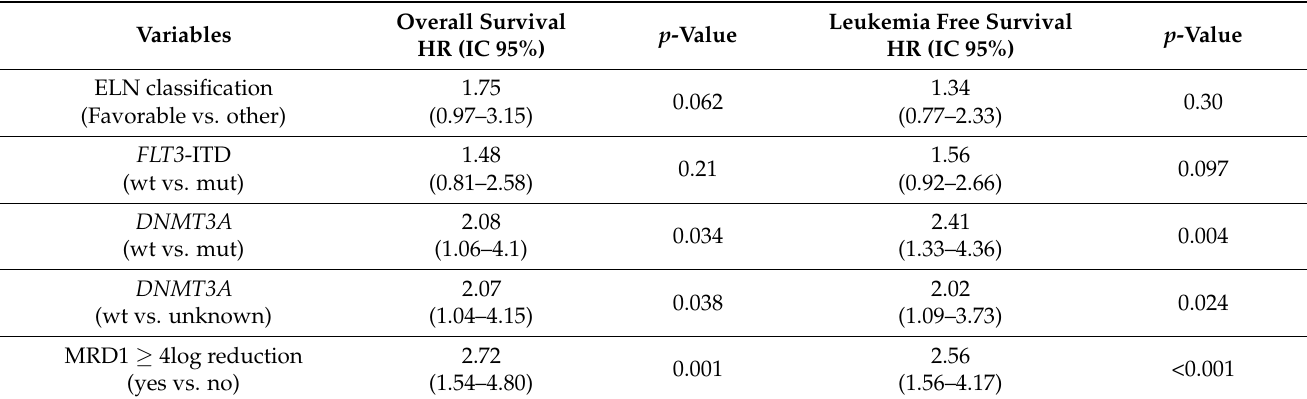
Table 2. Multivariate